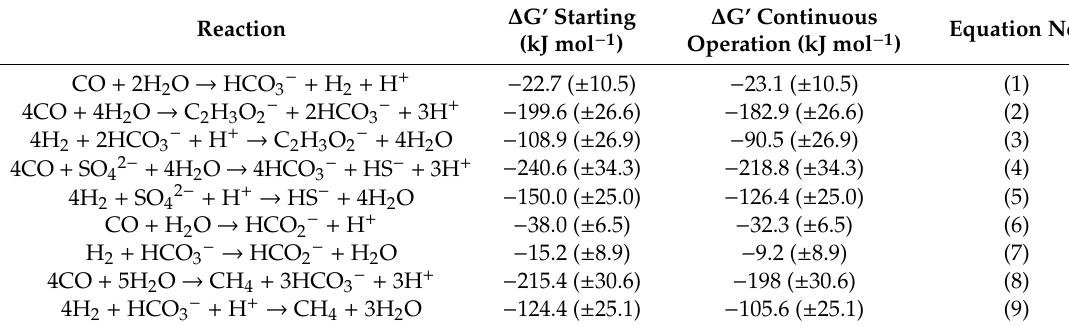
Table 1. Gibbs free energy under the bioreactor actual conditions ( ∆ G’) for di ff erent CO and H 2 consuming reactions at starting and continuous operation conditions. ∆ G’ Starting ∆ G’ Continuous Equation Reaction (kJ mol − 1 ) Operation (kJ mol − 1 )